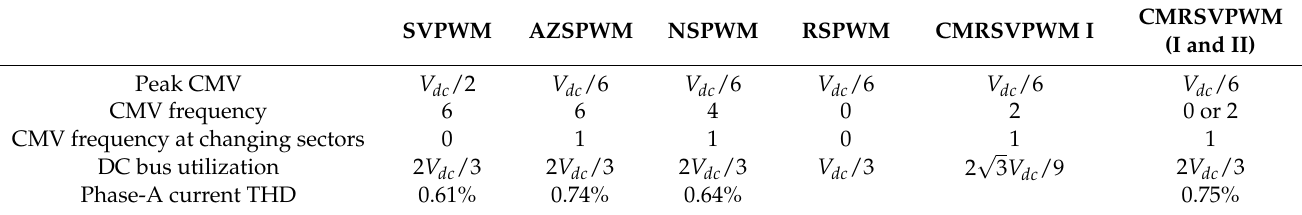
Table 6. Characteristic of different PWM modulation techniques targeting CMV improvement.